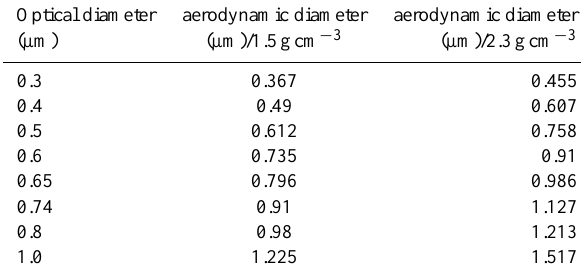
Table 2. Conversion table from Stokes to aerodynamic diameter following Baron and Willeke (2001) and assuming an average par- ticle density of 1.5g/cm 3 (Cozic et al., 2008b) and a density of 2.3g/cm 3 , representative of mineral dust average density. We as- sume a dynamic shape factor of 1 and that the optical diameter is equivalent to the Stokes